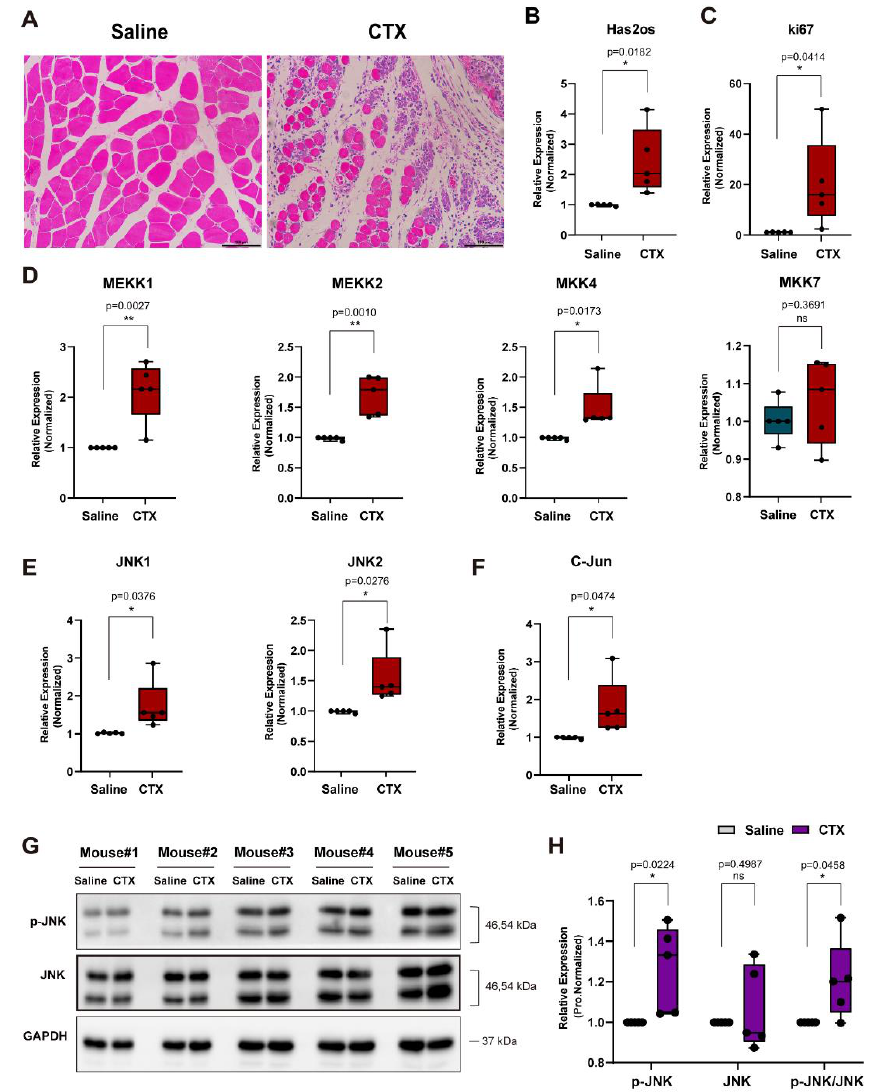
Figure 6. Has2os was involved in the early repair of muscle injury. ( A ). Immunohistochemistry results showed the morphology of injured muscle induced by CTX for 3 days. Scale bar = 100 µ m. ( B ). The expression levels of Has2os after muscle injury. ( C ) The mRNA expression levels of ki67 after muscle injury. ( D–F ). qRT-PCR assays of the key factors of the JNK/MAPK signaling (MEKK1, MEKK2, MKK4, MKK7, JNK1, JNK2, and c-JUN) after muscle injury. ( G ). Western blot analysis shows the protein expression of p-JNK and JNK after muscle injury. ( H ). Relative expression in ( G ) were calculated. GAPDH was the internal control. The results are normalized to those of with si-NC. Values were presented as means ± SEM. The statistical significance was calculated by t